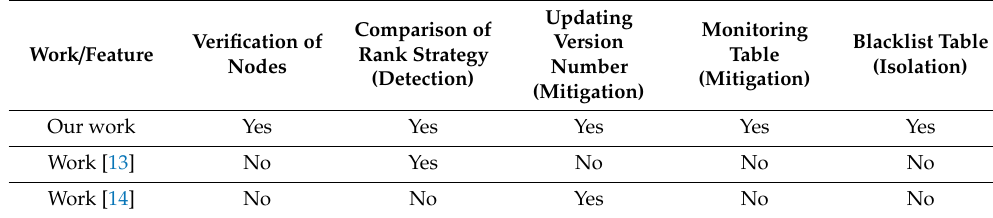
Table 1. Comparison of our Work and the Work of